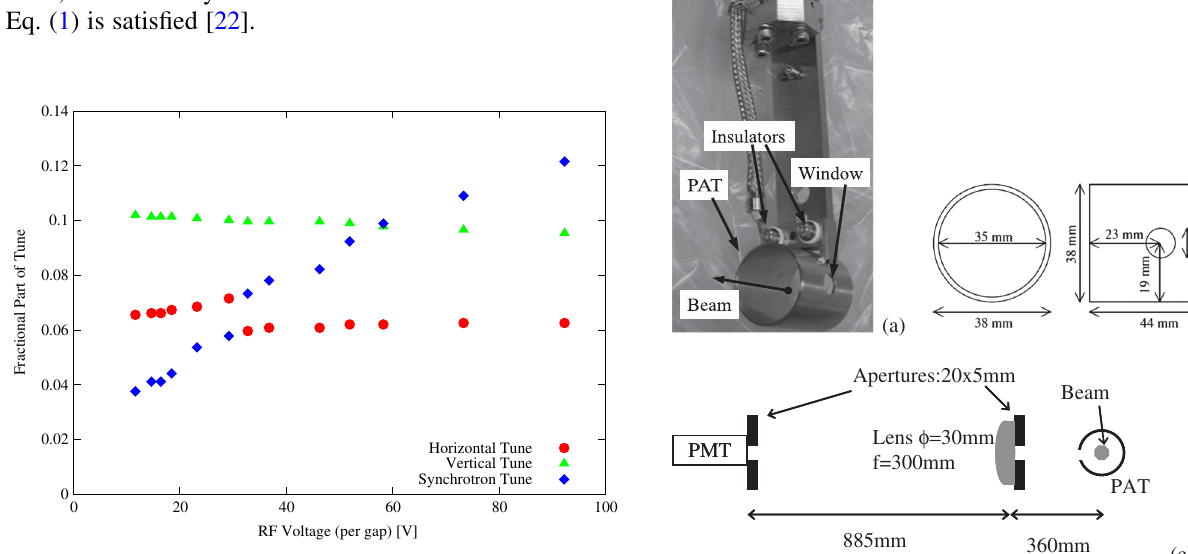
FIG. 7. The PAT system employed for momentum distribution measurements in S-LSR. (a) A photograph of the PAT and its support. The PAT is vertically inserted toward the beam (see Fig. 2) in the cooling section. (b) The geometry of the PAT. (c) The layout of the PAT